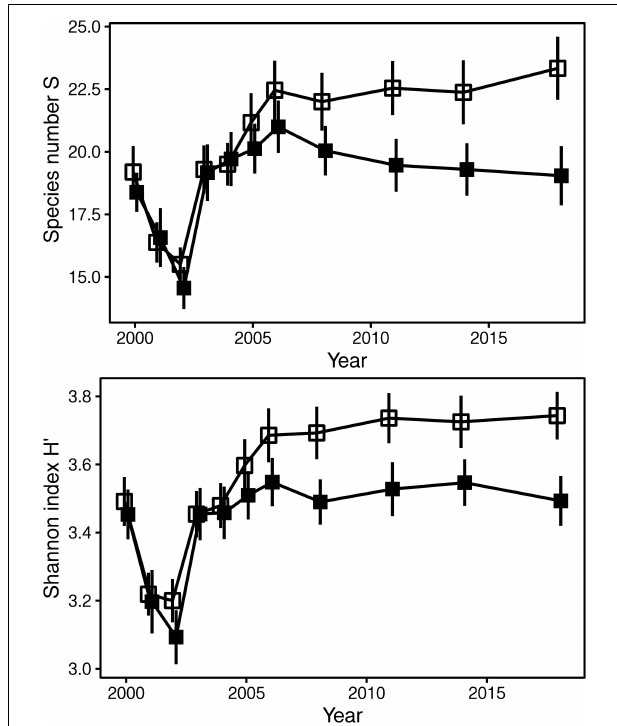
FIGURE 3 | Grazing effects on diversity [species number S and Shannon index H (cid:48) (log 2 )]: time courses for exclosure and control plots diverging after 5 years. Means ± S.E. for exclosure plots (filled squares) and grazed control plots (open squares). Sites with later installation of fences excluded (peat bog: fences in 2005).